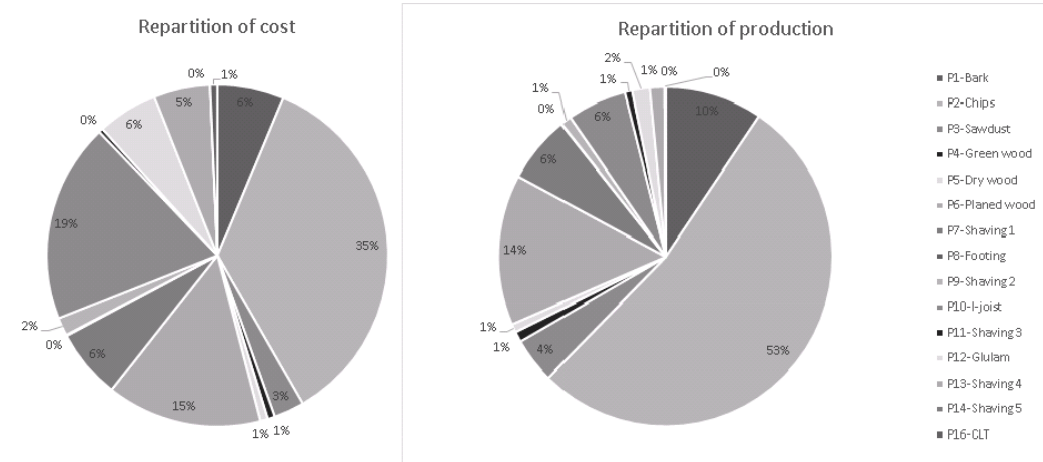
Figure 5: Comparison between the distribution of costs and production volume of the wood products